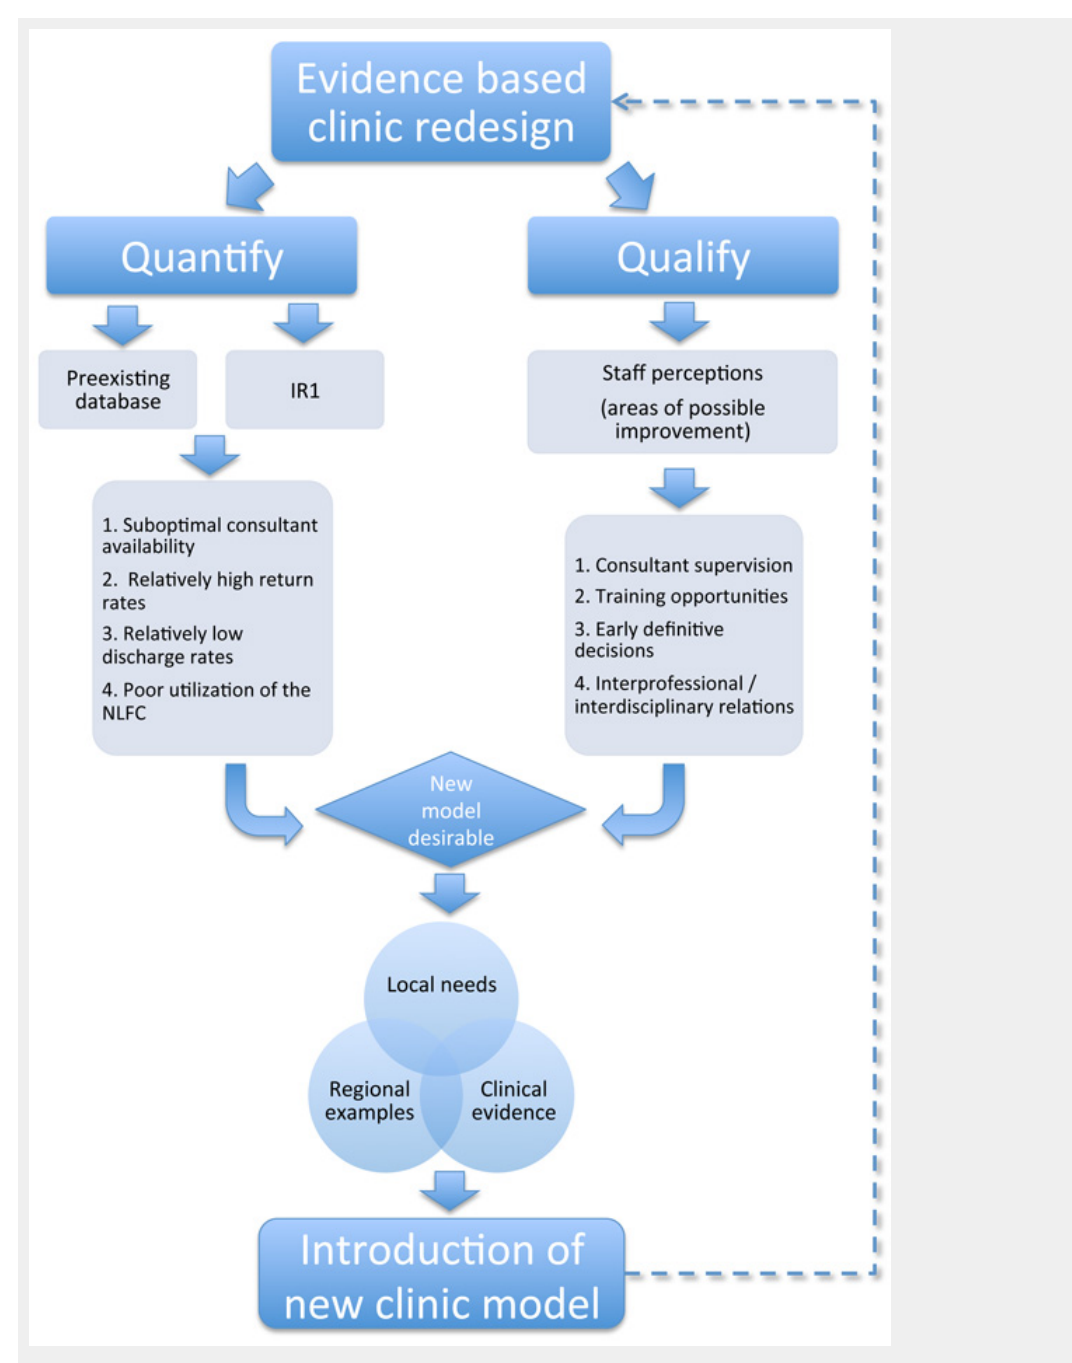
Figure 1 Implementation of new fracture clinic model using principles of evidence-based